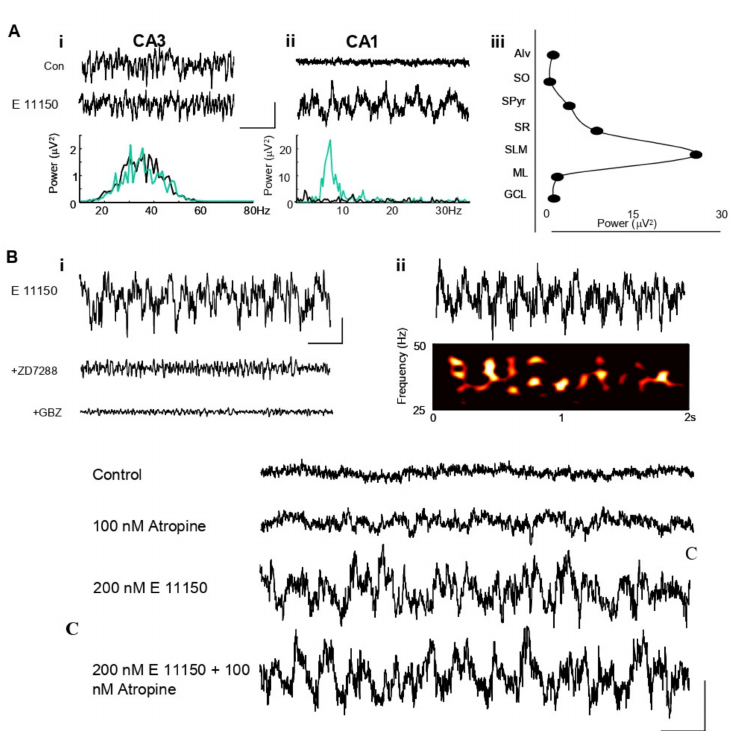
Figure 1. EGIS 11150 selectively generates a theta rhythm de novo in CA1 of hippocampal slices in vitro. ( A ). ( i ) Extracellular recordings from CA3 stratum radiatum show no effect of EGIS 11150. ( ii ) In stratum lacunosum molecular area of CA1, EGIS 11150 produces a persistent theta frequency rhythm. Scale bars 50 µ V 200 ms. ( iii ) Laminar profile of CA1 theta, recorded in the layers indicated with extracellular electrode shows a highly localised occurrence in stratum lacunosum. Aalveus (Alv), Stratum oriens (SO), Stratum pyramidale (SPyr), Stratum radiatum (SR), Molecular layer dentate gyrus (ML), Granule cell layer dentate gyrus (GCL). ( B ). ( i ) EGIS 11150-generated theta rhythms were blocked by GBZ (2 µ M) and ZD7288 (10 µ M). ( ii ) Spectogram of the EGIS 11150-generated gamma rhythms. ( C ) EGIS 11150 induced theta rhythm is not affected by a muscarinic component in hip- pocampal region CA1 in vitro. Extracellular recordings from CA1 stratum lacunosum show 200 nM EGIS 11150 generates a persistent theta frequency rhythm, which is unaffected by the muscarinic agent, atropine, at a concentration of 100 nM. Scale bars 50 µ V 200